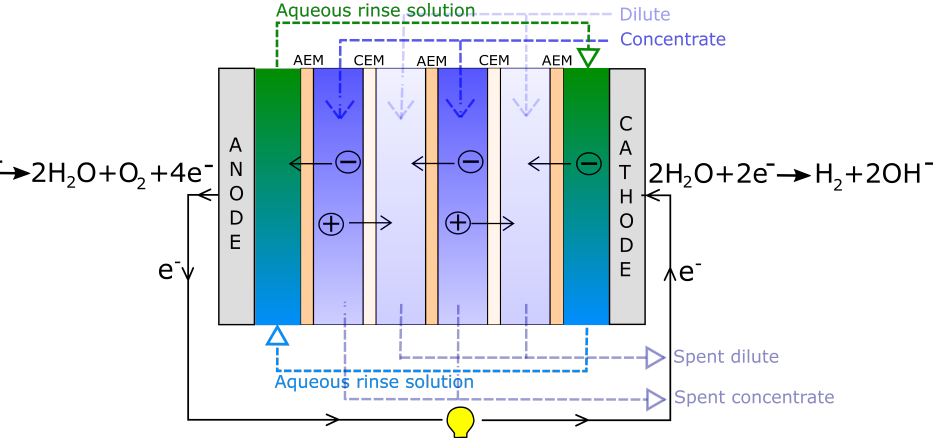
Figure 5. Illustration of a RED-cell. Hydrogen is produced at the cathode and oxygen at the